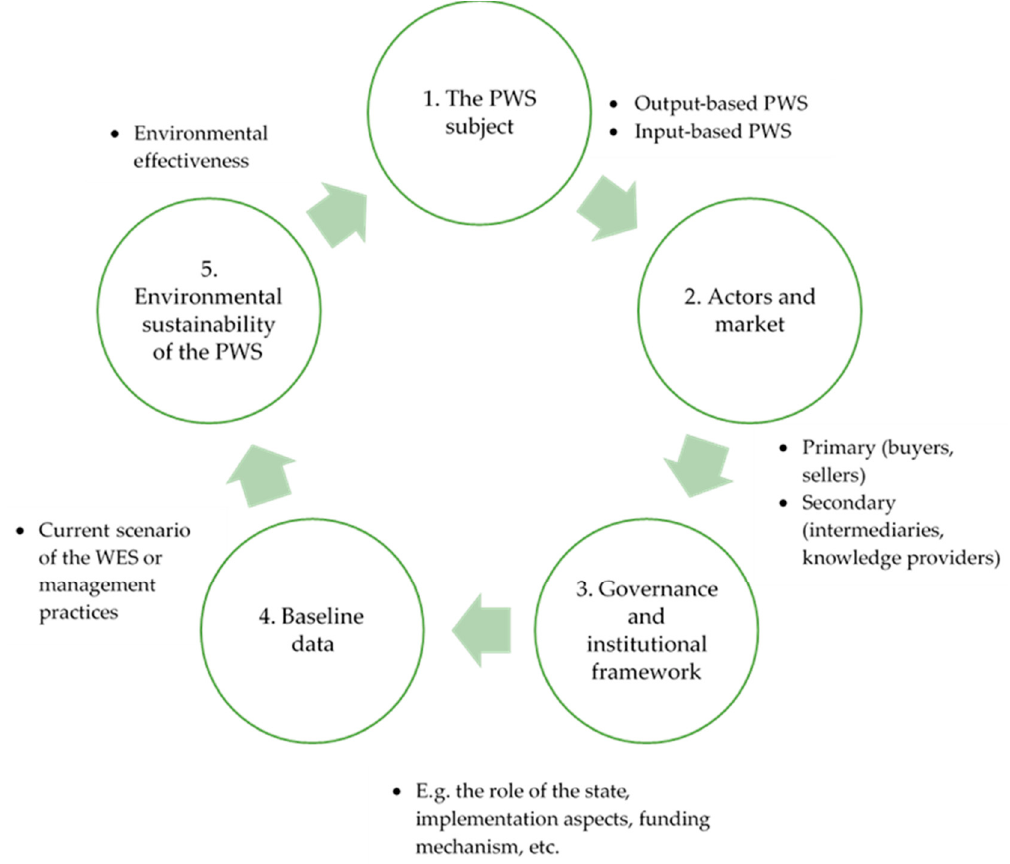
Figure 1. The basic model of payments for water-related services (PWS) design. The PWS design should be described in five basic steps: (1) The identification of PWS subject; (2) The identification of relevant actors, markets and funding mechanisms; (3) The design the key aspects of governance and institutional framework of PWS schemes; (4) Description of the current state of Water-related forest ecosystems services (WES) and management used (“business-as-usual”); (5) The assessment of the environmental outcome of PWS and relevant indicators.